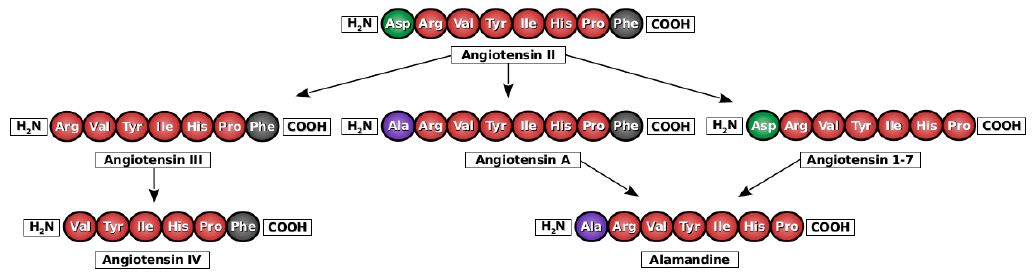
Figure 2. Amino acid sequences of angiotensin II, angiotensin III, angiotensin IV, angiotensin A,